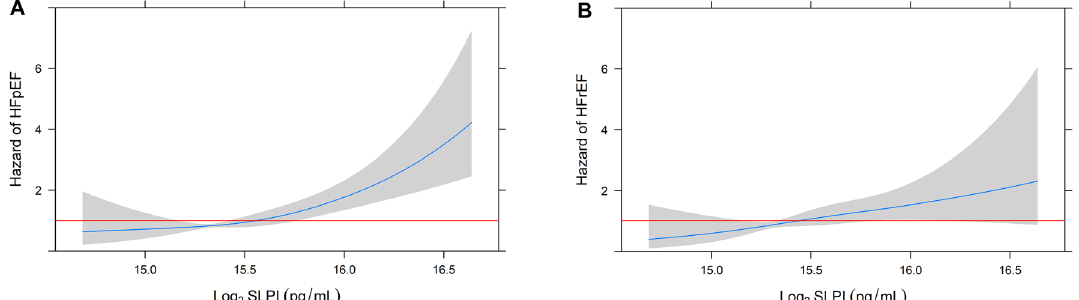
Figure 2. Association of serum SLPI with heart failure subtypes. ( A ) Restricted cubic spline curves of the continuous association of SLPI with heart failure with preserved ejection fraction (HFpEF). ( B ) Restricted cubic spline curves of the continuous association of SLPI with heart failure with reduced ejection fraction (HFrEF). Log base 2 transformation of SLPI can be interpreted as “per doubling.” Horizontal red line indicates a hazard ratio (HR) of 1. Shaded areas represent 95% confidence interval